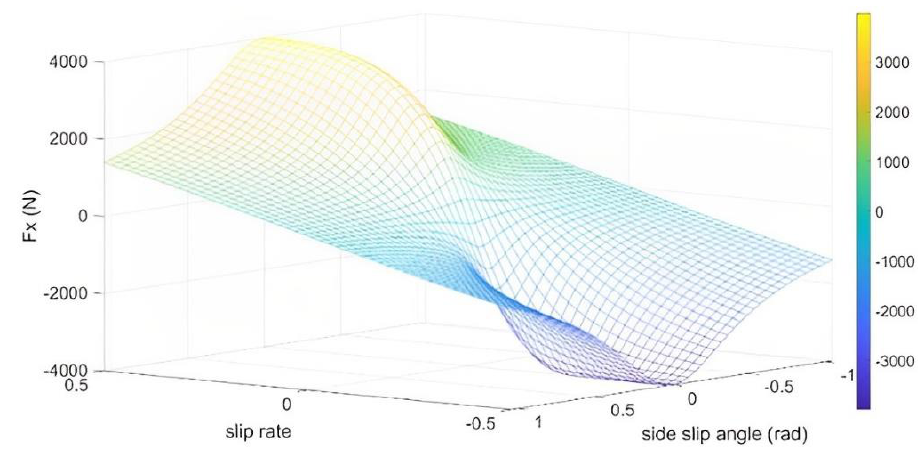
Figure 4. Longitudinal forces calculated by the Brush model.